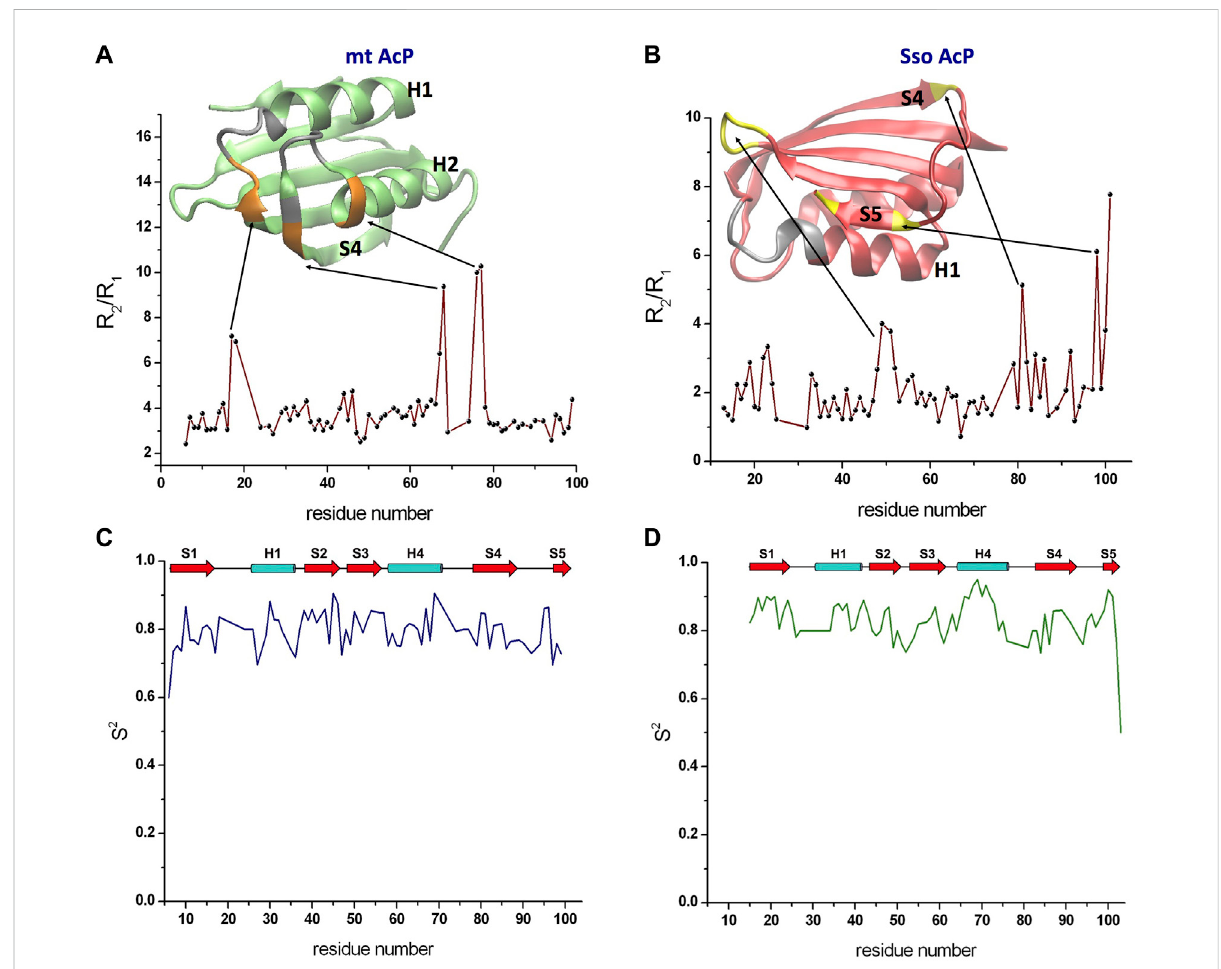
FIGURE 1 Nanosecond dynamics from 15 N Relaxation experiments. (A) R 2 /R 1 values along the sequence of mt AcP at 37 ° C showed a uniform distribution ofvaluesfortherigidregions,whereashighratiosidenti fi edresiduesinconformationalexchangeonslowertimescales.Theribbonrepresentationof the protein structure is shown in green, with silver regions indicanting residues whose resonances are broadened beyond detection and orange regions showing residues with high R 2 /R 1 values. (B) R 2 /R 1 values along the sequence of Sso AcP at 80 ° C. The protein structure is shown using redribbonsandbycoloringinyellowandsilvertheregionswithhighR 2 /R 1 valuesandresonancebroadening,respectively. (C,D) OrderparametersS 2 valuesof mt AcP at 37 ° C (C) and Sso AcP at 80 ° C (D) calculated using data from 15 N relaxation and the model free